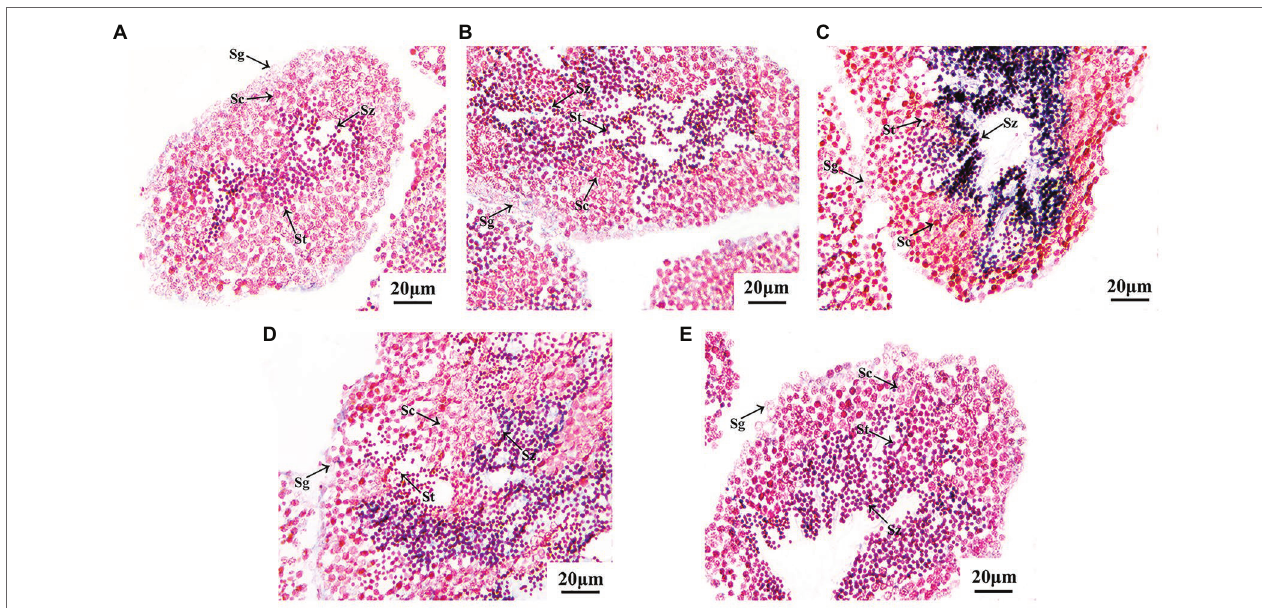
FIGURE 5 | Localization of A. irradians Tssk genes in mature testes by in situ hybridization with the anti-sense probes. (A–E) Represent Tssk1/2, Tssk3, Tssk4, Tssk5, and Tssk7, respectively. Sg, spermatogonium; Sc, spermatocyte; St, spermatid; Sz,